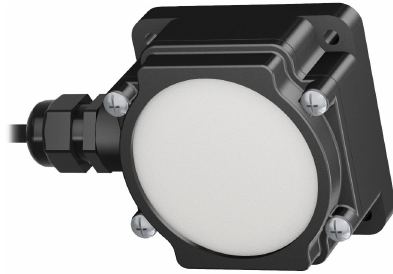
Figure 11. LED light indicator as active marker for object point signaling. Image according to